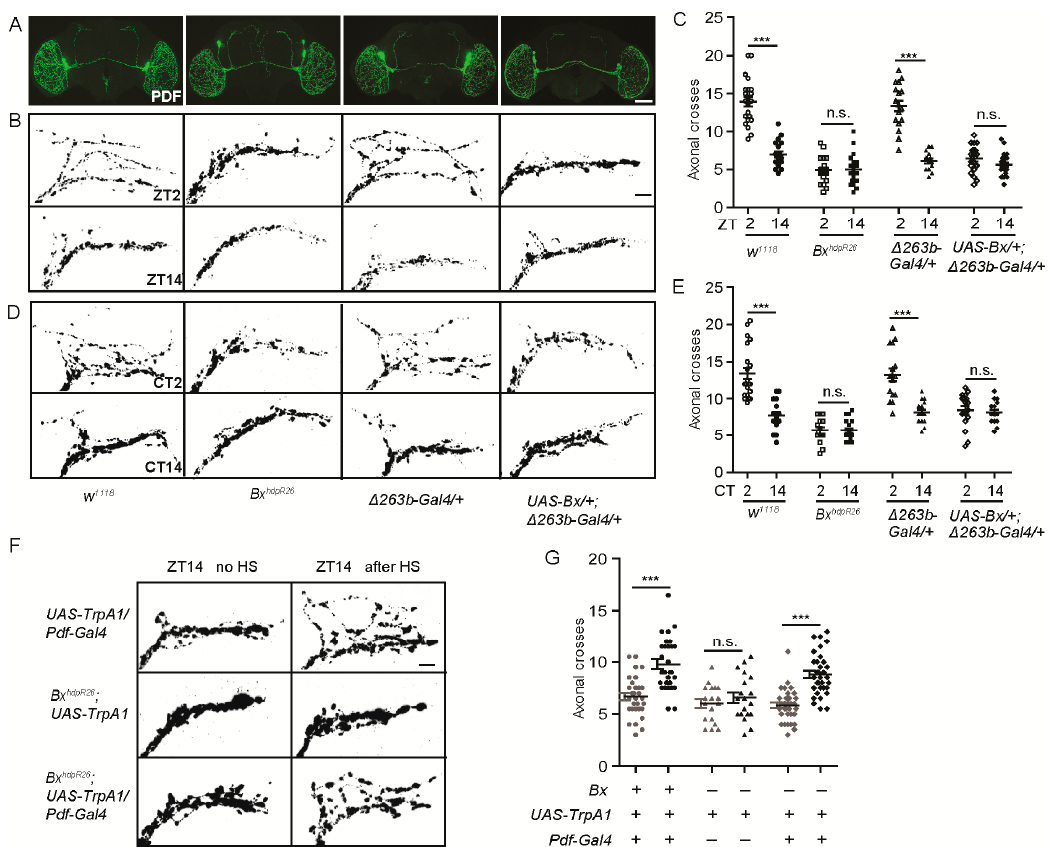
Figure 6. Bx regulates the arborization rhythms of sLNv dorsal projections. ( A ) Representative confocal images of brains of the indicated genotypes stained for PDF at ZT2; scale bar, 75 µm. ( B ) Dorsal projections of sLNvs at ZT2 and ZT14. Flies were entrained for at least three days under LD conditions prior to the assay; scale bar, 10 µ m. ( C ) Quantification analysis of axonal morphology (fasciculation) of sLNv dorsal termini in LD conditions by Sholl’s analysis. Data represent means ± SEM ( n = 15–23); n.s. not significant, *** p < 0.001 determined by Student’s t -test. ( D ) Representative confocal images of the projections at CT2 or CT14 during the second day of DD; scale bar, 10 µ m. ( E ) Quantification of axonal morphology of sLNv dorsal termini in DD conditions. Data represent means ± SEM ( n = 15–21); n.s. not significant, *** p < 0.001 determined by Student’s t -test. ( F ) Confocal images of sLNv projections from flies stained with anti-PDF at ZT14. Conformation changes in response to 2-h temperature elevation (HS) are shown on the right. The left shows a control not subjected to temperature elevation. ( G ) Quantification of TrpA1 -induced changes in axonal fasciculation. Data represent means ± SEM ( n = 19–34); n.s. not significant, *** p < 0.001 determined by Student’s t -test.